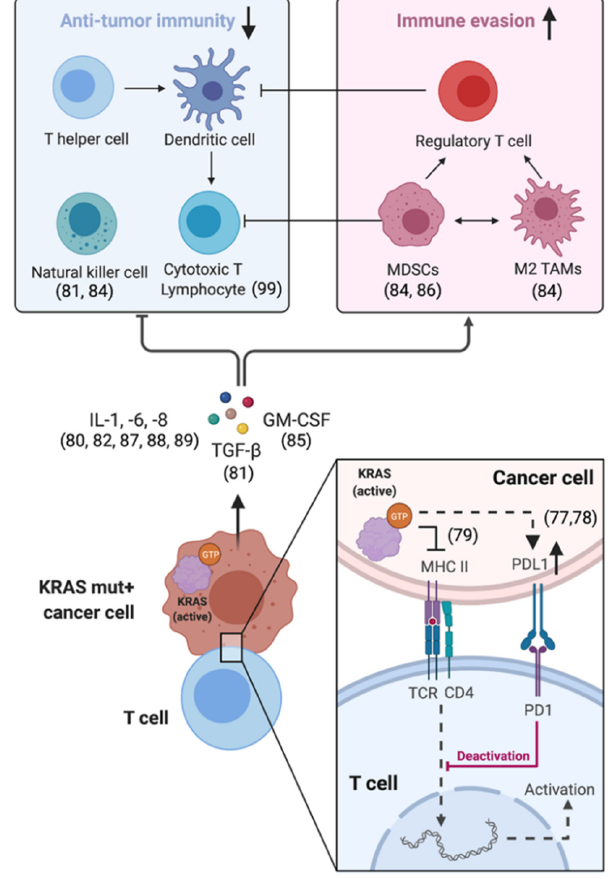
Figure 1. Simplified overview of mutant- KRAS -dependent effects on the surrounding tumor microenvironment via direct cell-to-cell interactions and/or paracrine secretion of interleukins, GM-CSF and TGF β . These paracrine signals induce the accumulation of myeloid-derived suppressor cells (MDSCs), M2-differentiated tumor-associated macrophages (TAMs) and regulatory T cells, which impair antitumor immunity by suppressing T-cell effector functions. References are displayed in brackets.